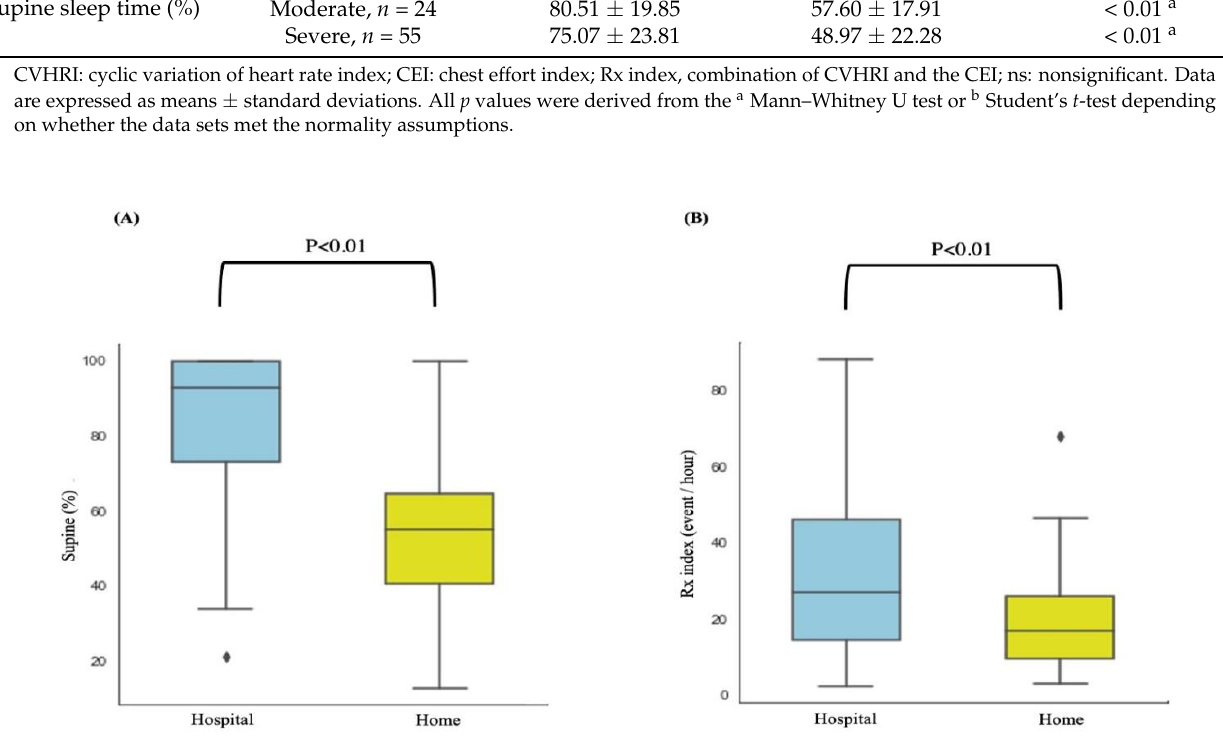
Figure 4. Variation of the percentage of supine sleep time and the Rx Index values determined in hospital and home settings in the high-sleep-efficiency group ( ≥ 90%; n = 46): ( A ) variation in the percentage of supine sleep in various sleep environments; ( B ) variation in Rx index values in various sleep environments. Abbreviations: Rx index, combination of the cyclic variation of heart rate index and the chest effort index.